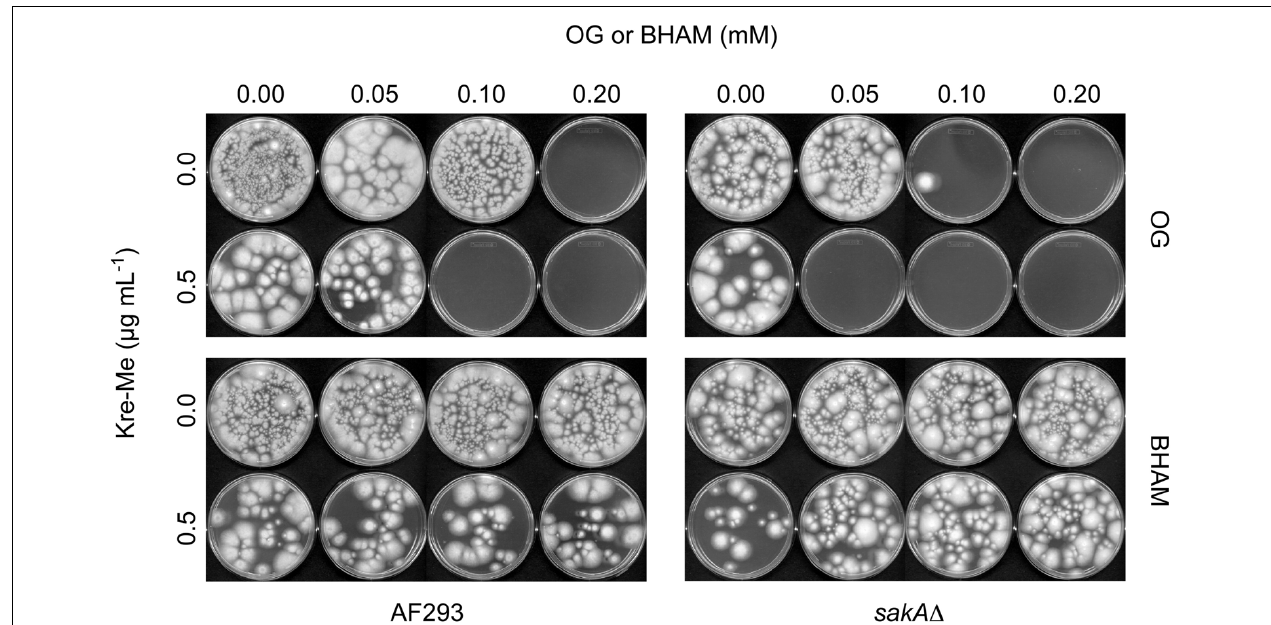
FIGURE 4 | Chemosensitization test in A. fumigatus : Kre-Me + OG or BHAM. Results shown here are the determination of MFCs of antifungal agents. Co-application of Kre-Me (0.5 µ g mL − 1 ) with OG (0.10 or 0.05mM for A. fumigatus WT or sakA (cid:2) , respectively), completely inhibited the growth of A. fumigatus , while individual treatment of each compound, alone, at the same concentrations allowed the growth of fungi. The sakA (cid:2) mutant was also more sensitive (viz. required lower concentration of OG)